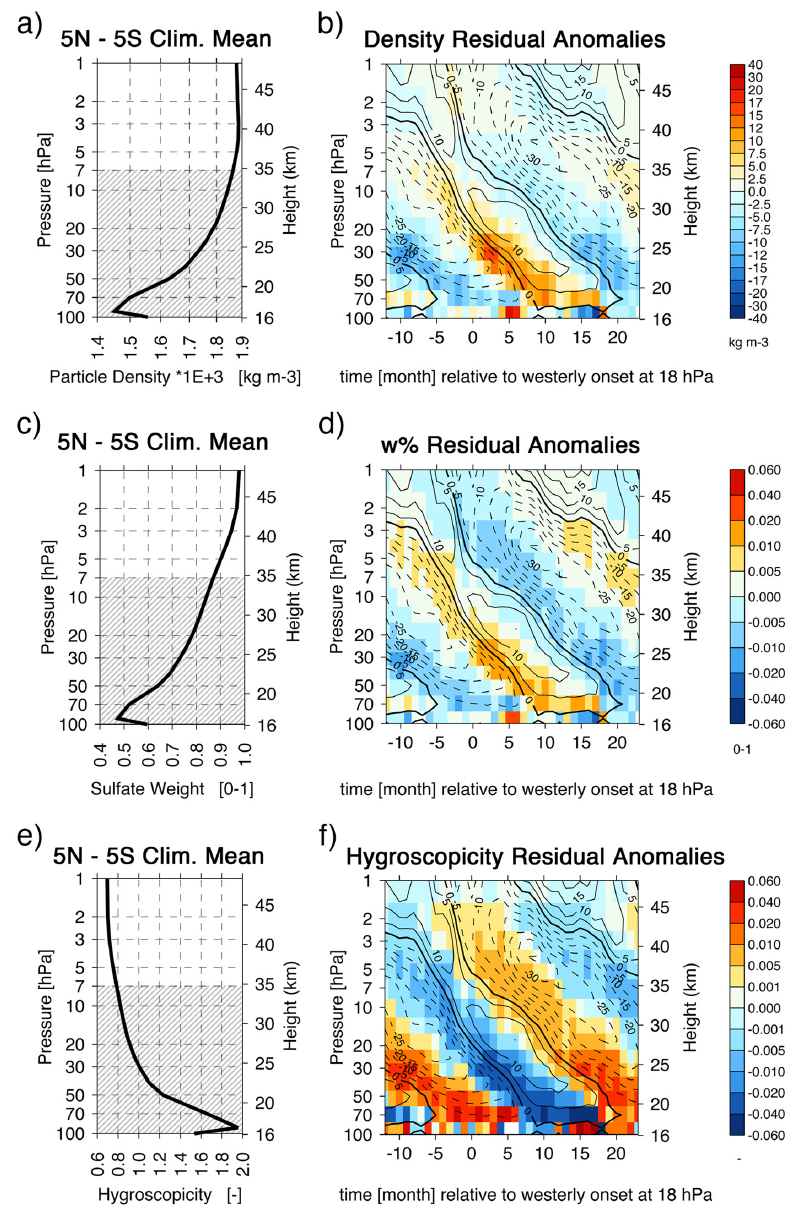
Figure 12. As in Fig. 6, except for modelled sulfate aerosol properties. The upper panel shows the density of the binary H 2 SO 4 − H 2 O solution, the middle panel the H 2 SO 4 weight percentage, and the bottom panel the aerosol water content relative to a representative Junge layer aerosol composition (e.g. Rosen,